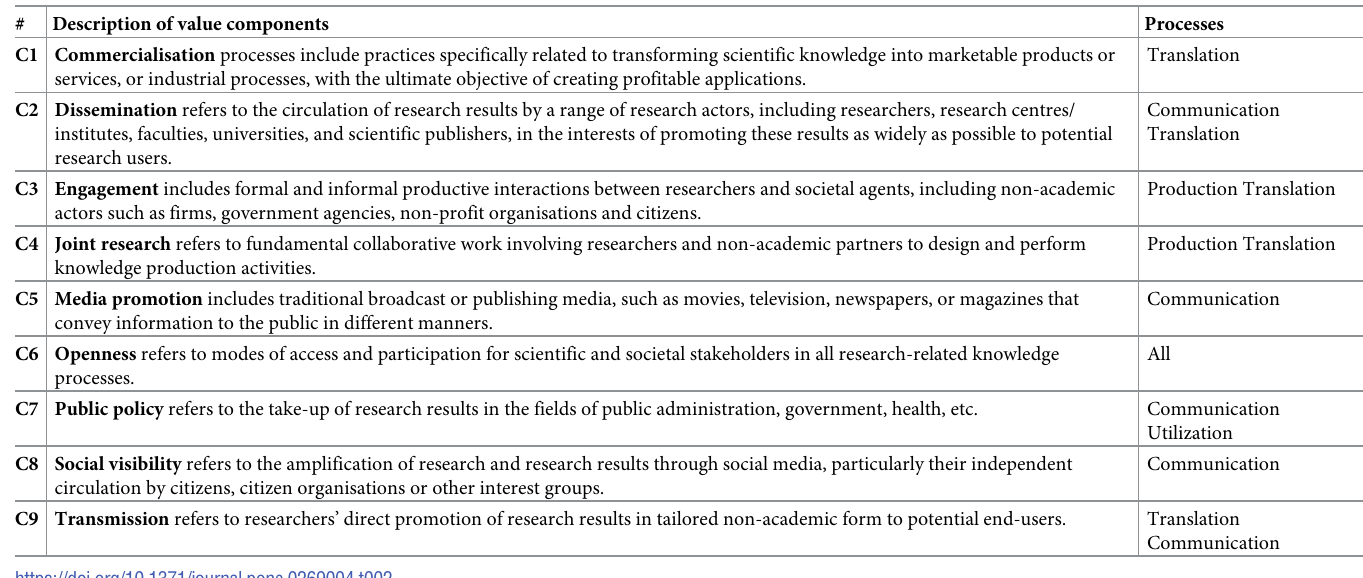
Table 2. Value components: Description and predominant research-related knowledge